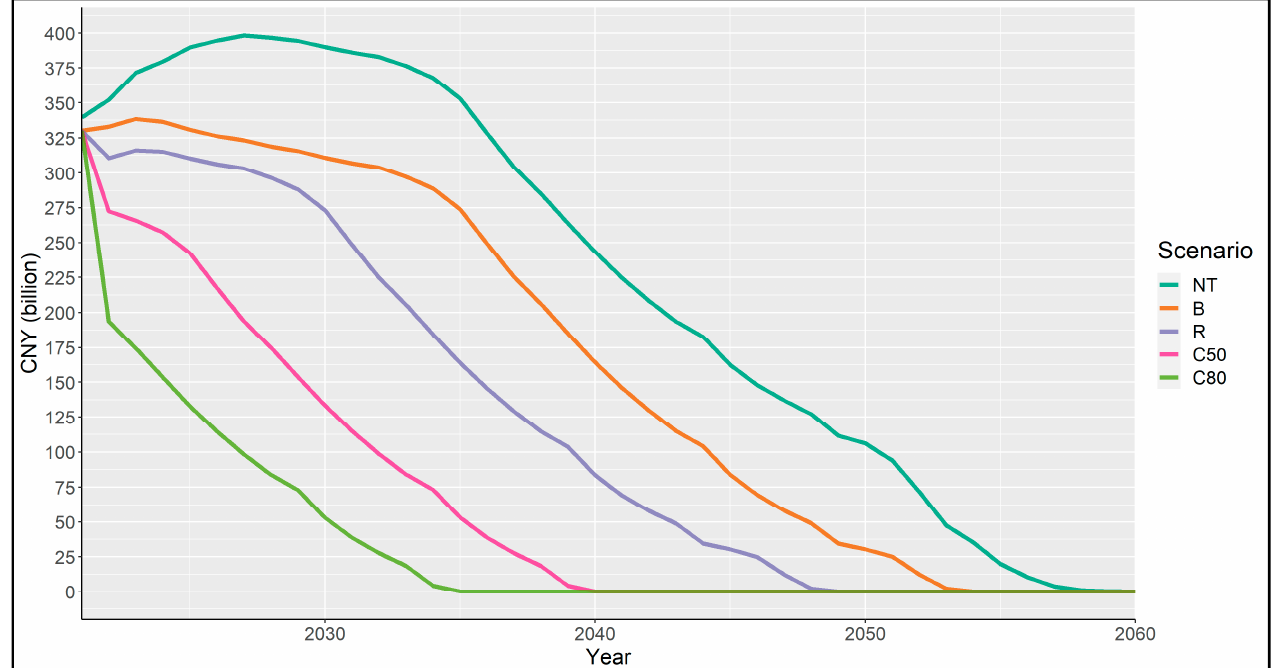
Figure 7. Total tax revenues under different coal phase-out scenarios, 2021–2060.